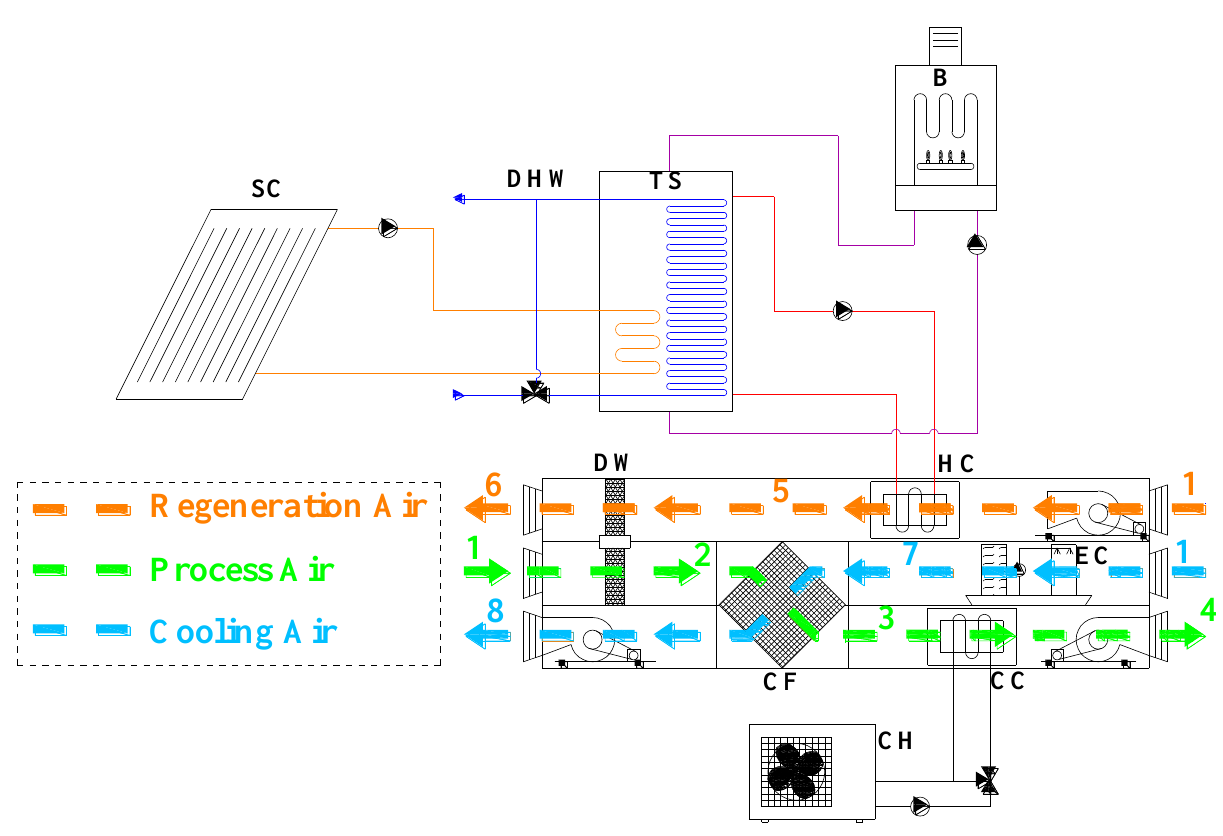
Figure 1. The layout of the desiccant-based air-handling unit